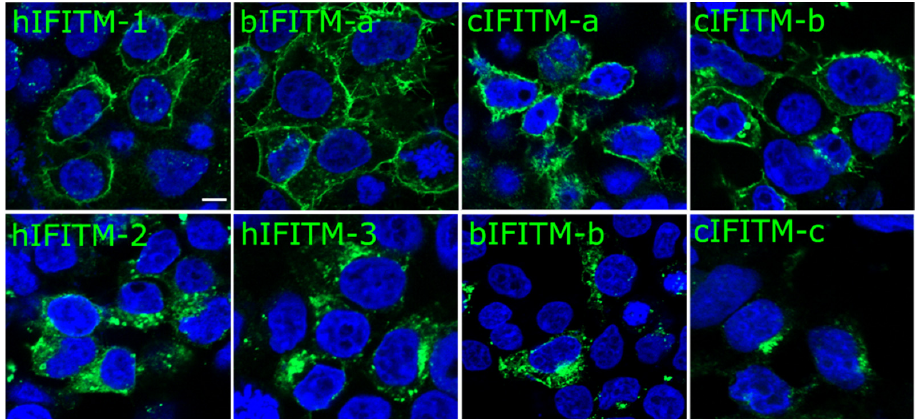
Figure 3. Cellular localization of human, bovine, and camel IFITMs, as indicated. HEK293T cells were transfected with plasmids encoding the different IFITMs. Twenty-four hours post-transfection, the cells were fixed with PFA and immuno-stained for IFITMs with an anti-HA antibody followed by a secondary antibody conjugated to Alexa488 (Green). Cell nuclei were labelled with DAPI stain- ing (blue). Representative pictures of IFITMs expressing cells are shown. The scale bar in the upper left panel represents 5 µm. hIFITM-1, human IFITM-1; hIFITM-2, human IFITM-2; hIFITM-3, human IFITM-3; bIFITM-a, bovine IFITM-a; bIFITM-b, bovine IFITM-b; cIFITM-a, camel IFITM-a; cIFITM- b, camel IFITM-b; cIFITM-c, camel IFITM-c. 3.2. IFITMs from Naturally Infected Species Differentially Restrict TOSV and RVFV We then studied the ability of human, bovine, and camel IFITMs to inhibit TOSV and RVFV replication. To this end, we transfected HEK293T cells with human, bovine, or camel expression plasmids for IFITMs or with pcDNA as a control. Twenty-four hours post-transfection, we infected these cells with TOSV or RVFV and compared the amount of viral Nucleocapsid proteins (N) in transfected cells. We found that TOSV N protein levels were significantly decreased in the presence of all the IFITMs ( p < 0.0001; Kruska– Wallis test), and more potently so by hIFITM-2, bIFITM-a, and bIFITM-b (Figure 4A,C). Similarly, we observed that all the IFITMs, with the exception of hIFITM-1, were able to reduce RVFV N protein levels, albeit with differences between hIFITM-2, hIFITM-3, bIFITM-b, cIFITM-b, and cIFITM-c that all displayed a higher restriction effect with higher statistical significance ( p < 0.01; Kruskal–Wallis test) than bIFITM-a and cIFITM-a ( p = 0.024 and p = 0.013, respectively). Interestingly, and unlike other IFITMs, cIFITM-c strongly decreased RVFV N protein to barely detectable levels, while hIFITM-1 signifi- cantly increased it ( p < 0.001; Figure 4B,D).